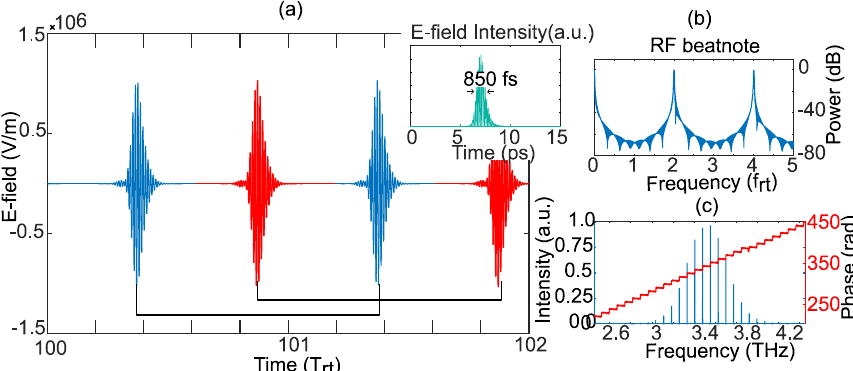
Fig. 2. (a) Time domain profile of the electric field inside the cavity, over time duration of two round trip times (Trt). (Inset) electric field intensity versus time of a single pulse. (b) A log plot of the beatnote signal versus round-trip frequency frt. (c) Optical spectrum and modal phase of the field emitted from the right facet of the